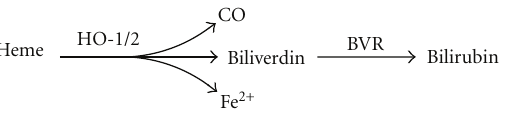
Figure 1: Heme catabolism initiated by heme oxygenases. Heme oxygenase-1 and 2 (HO-1/2) degrade heme to carbon monoxide (CO), Fe 2+ , and biliverdin that is then reduced to bilirubin by biliverdin reductase (BVR).